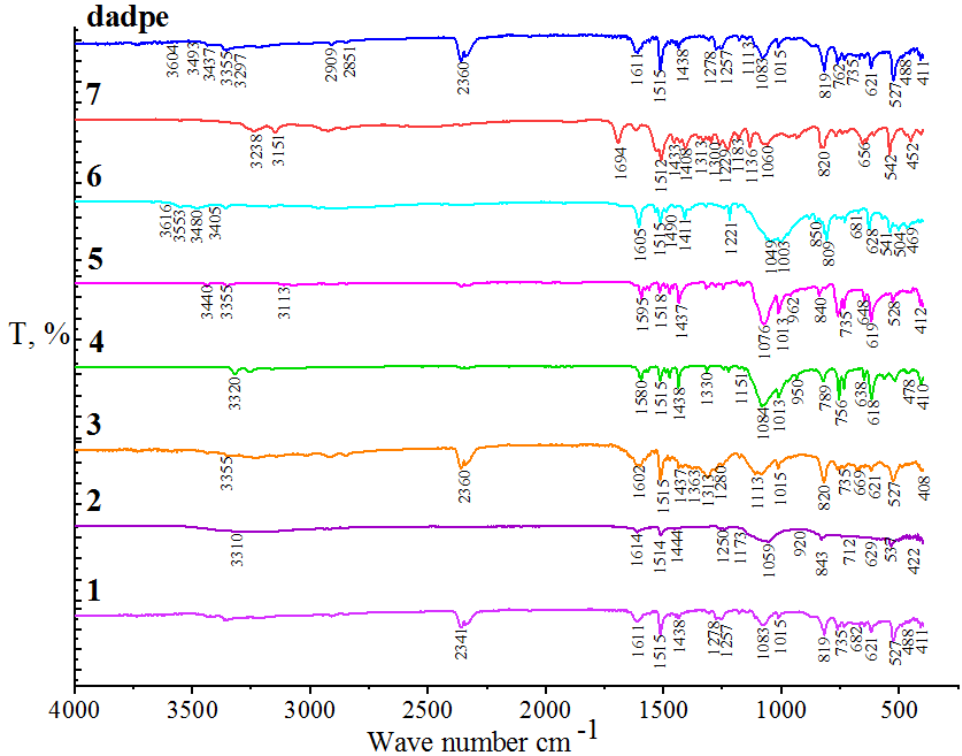
Figure 1. Combined diagram of IR spectra for 1–7 and dadpe ligand.